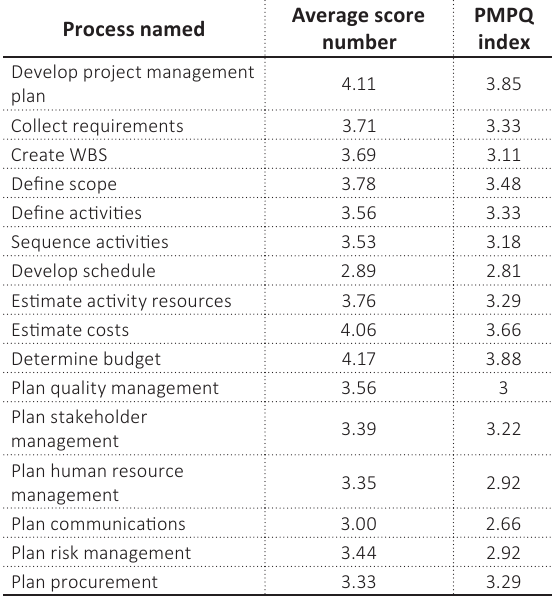
Table 1. Relationship between PM processes and project